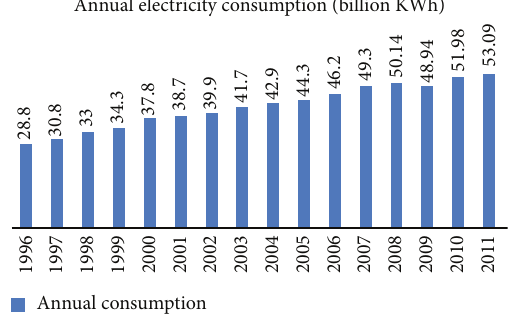
Figure 2: 1996–2011